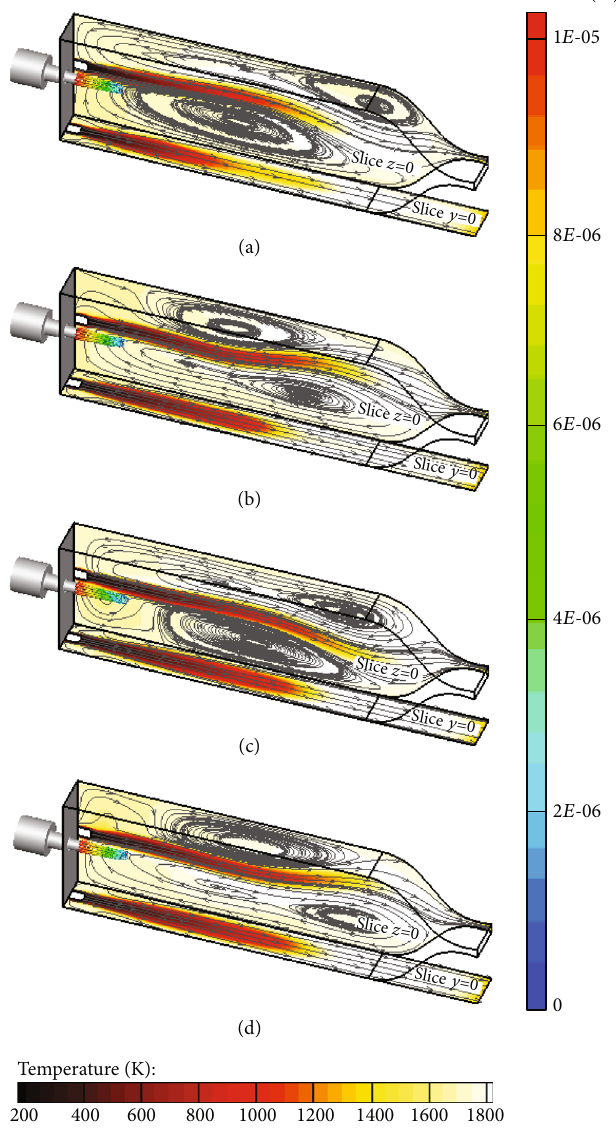
Figure 7: LOX particle traces and distribution of temperature fi elds and streamline in y = 0 and z = 0 planes for di ff erent mesh resolutions: (a) mesh A; (b) mesh B; (c) mesh C; (d) mesh